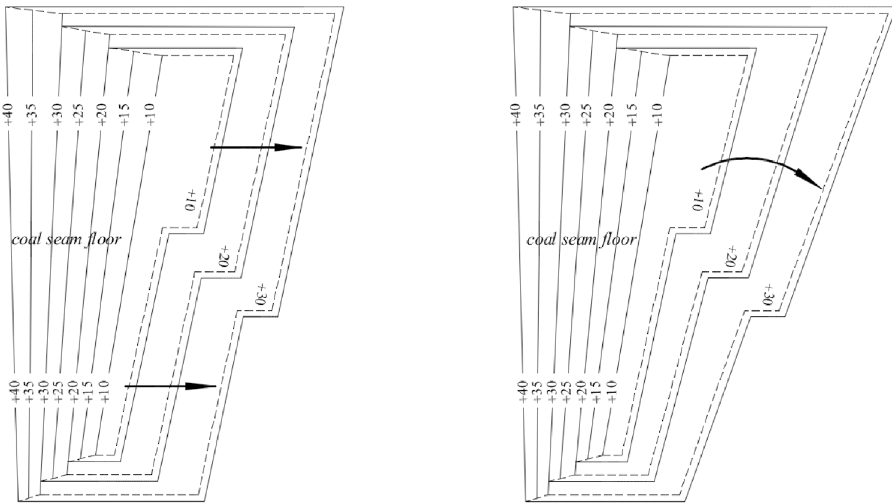
Fig. 7 Layout and develop- ment mode of Z-shaped work- ing line in steeper anticline